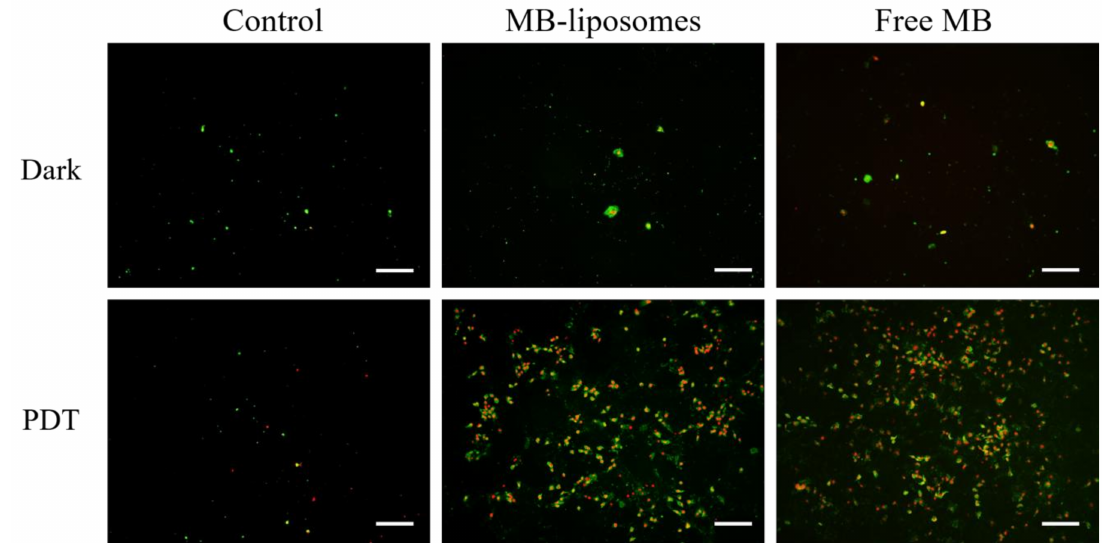
Figure 6. Fluorescence images of Annexin V-FITC (green) and PI (red) after 24 h treatment. Scale bar, 200 µ m.